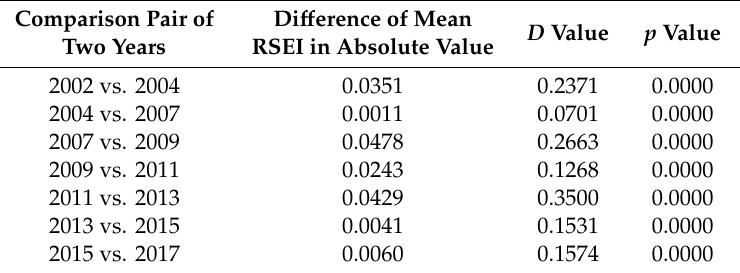
Table 2. The K-T test results.